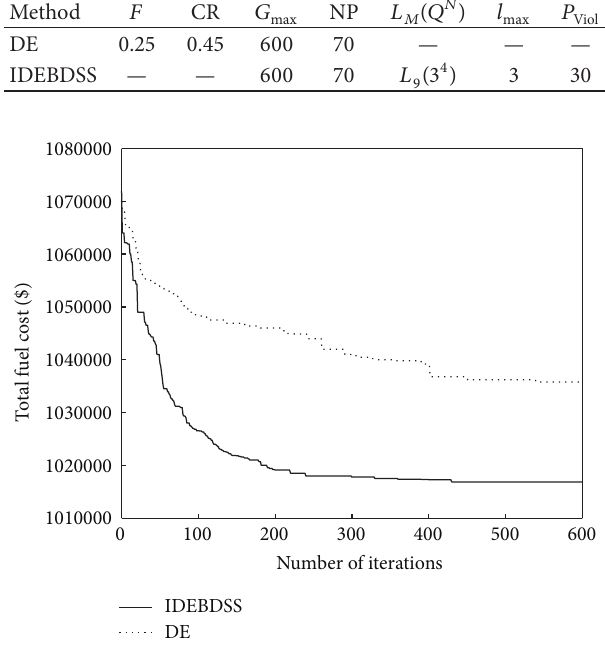
Figure 3: Convergence process of the best solution obtained by IDEBDSS and DE methods for test system